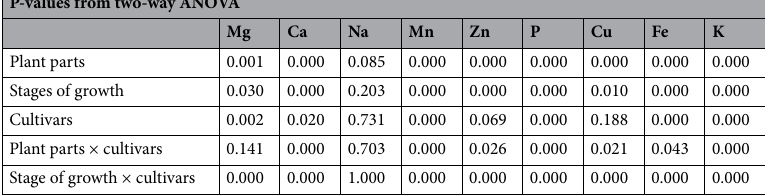
P-values from two-way ANOVA